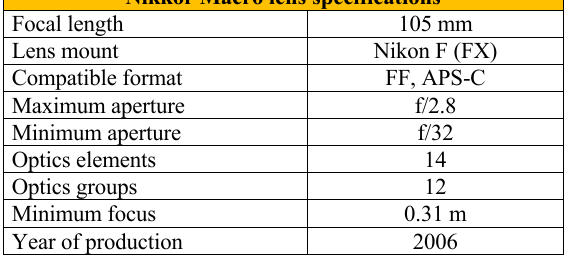
Table 2. Nikkor macro lens specifications.